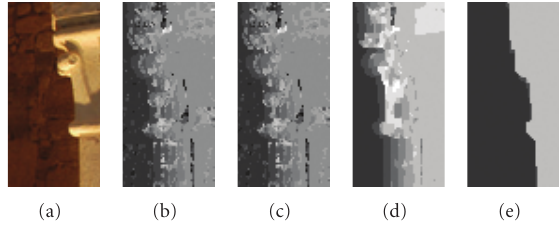
Figure 7: Extracts of Figures 5, 6(a), 6(b), 6(e), and